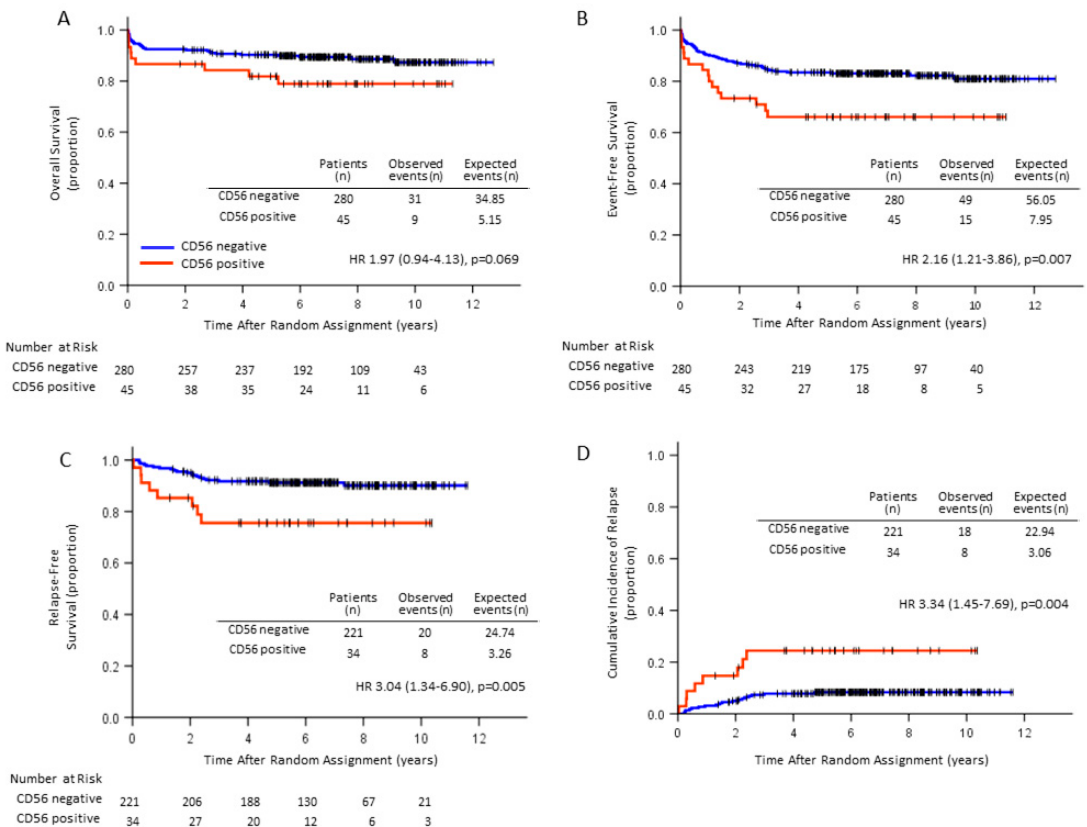
Figure 3. Long-term Kaplan–Meier curves of OS ( A ), EFS ( B ), RFS ( C ) and CIR ( D ) according to CD56 expression. EFS, RFS and CIR were inferior in CD56 + APL ( p = 0.007, p = 0.005, p = 0.004, respectively) than CD56 - APL, while OS was not significantly different between the two groups ( p = 0.069).